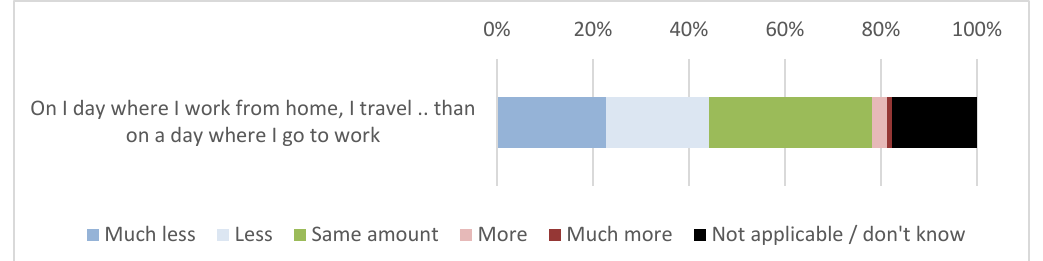
Figure 4. Amount of travel on a day working from home, compared to a commuting day (Data: MPN, COVID-Measurement of May 2022, N =